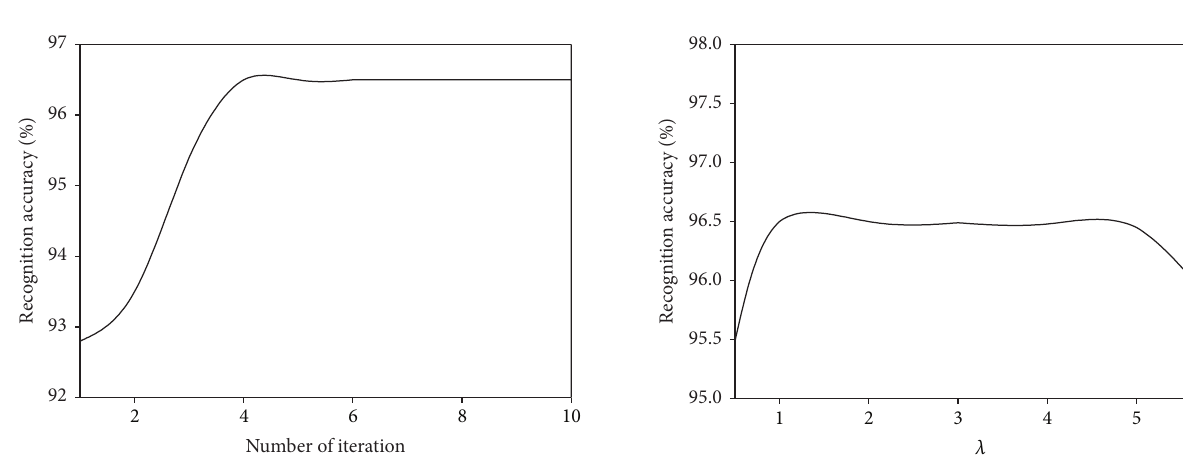
Figure 9: Recognition accuracy of MDGPP versus different num- bers of iteration on the JAFFE database.